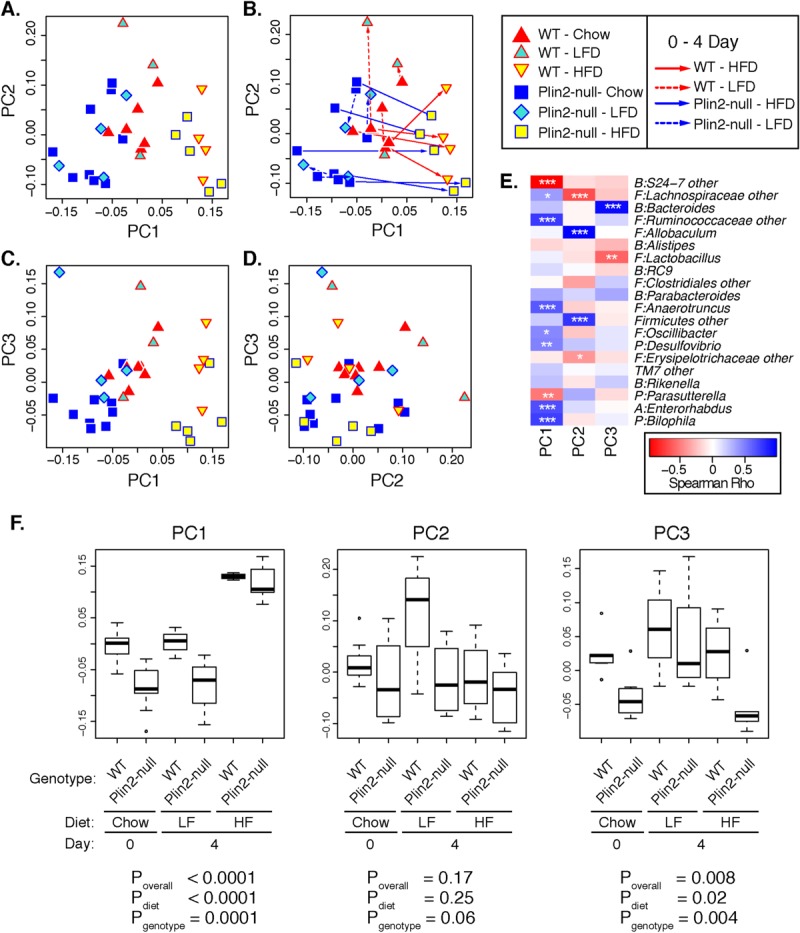
Principal components analysis of fecal microbiomes.PCA was carried out on genus-level microbiome datasets, as described in the text. PC1, PC2, and PC3 accounted for 35.3%, 26.8%, and 15.7% of the total variance in the dataset (77.8% cumulative proportion). Microbiomes from individual fecal samples, color-coded by genotype and diet, are plotted along the first three PC axes in Panels A, C, and D. Panel B displays the same plot as Panel A, but with arrows connecting pairs of samples from the same animals on different diets. Panel E displays a heat-map color-coding Spearman correlation coefficients between PC scores and the abundances of prevalent OTUs (abundances >1%) in fecal samples. OTU names are prefixed by letters indicating phyla classifications of the OTUs: A: Actinobacteria, B: Bacteroidetes, F: Firmicutes, P: Proteobacteria; T: TM7. Asterisks depict p-values for correlations: *: p<0.1; **: p<0.05; ***p<0.001. Blue shading indicates positive correlations, while red shading indicates negative correlations. OTUs that could not be classified to the genus level are labeled by adding “other” to the higher-order taxonomic assignment.